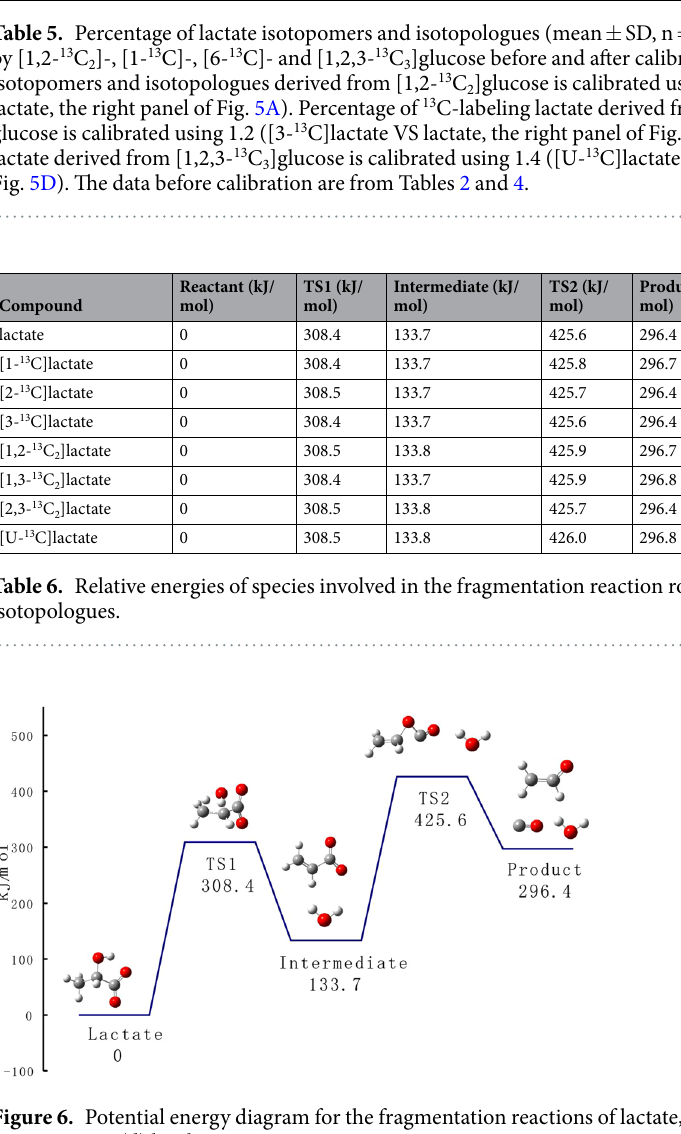
Figure 6. Potential energy diagram for the fragmentation reactions of lactate, using DFT calculations at the B3LYP/6-31 G(d) level.